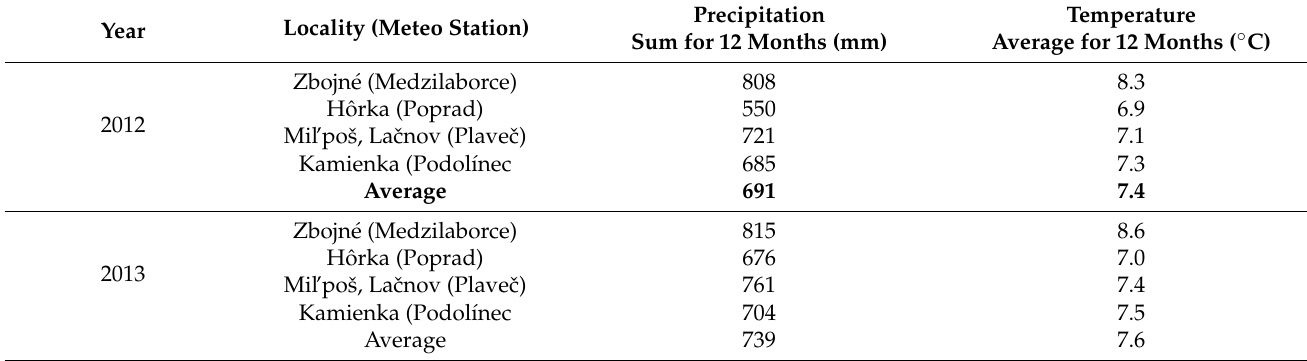
Table 4. The changes of the sum of precipitation and average temperature in observed localities within three years of